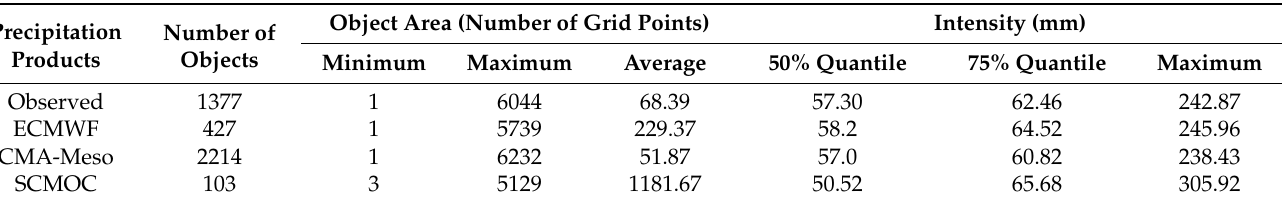
Table 3. Comparison of rainstorm independent object attributes identified by MODE methods of observation and the three precipitation